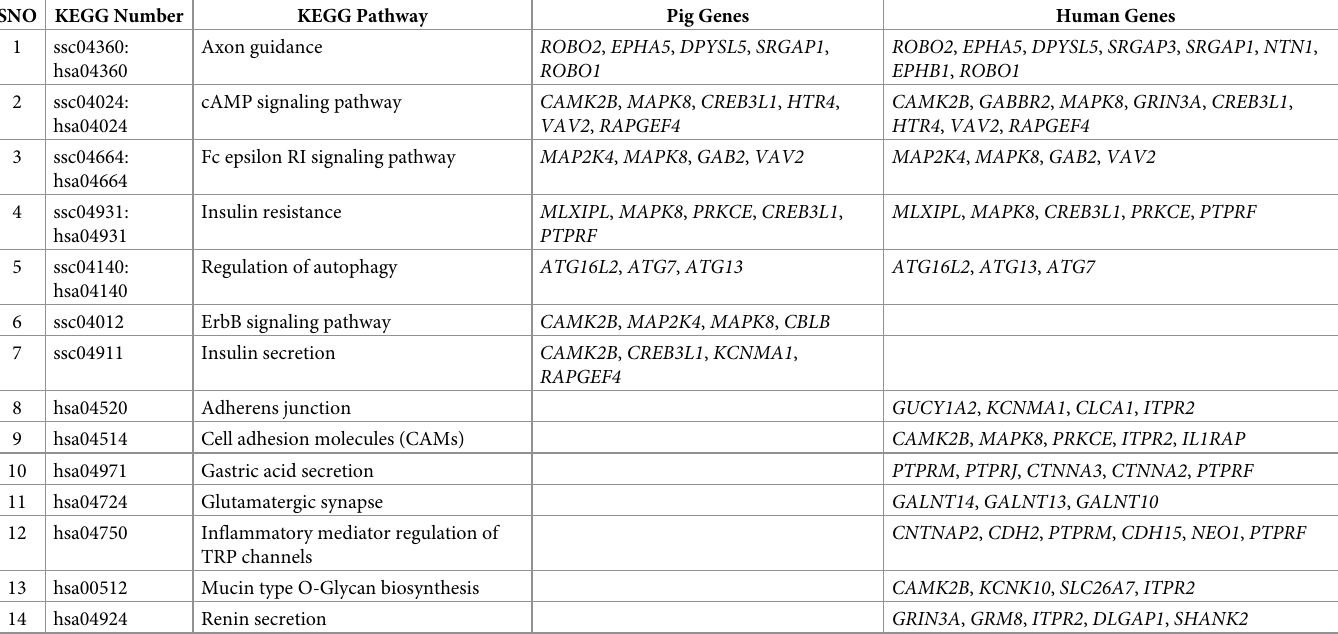
Table 2. Comparison of KEGG pathways enriched in Pig and Human for selective sweep